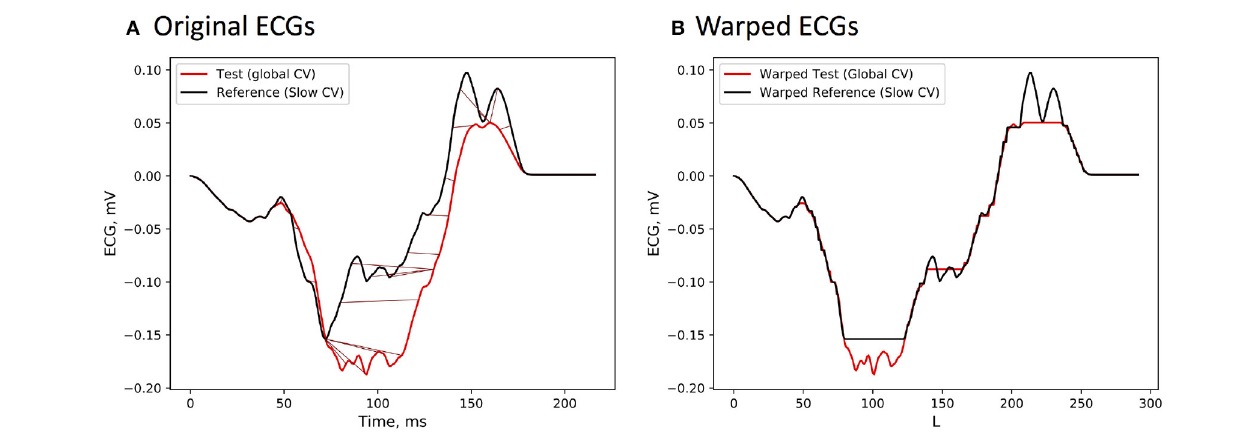
FIGURE 2 | (A) ECG signals from the reference BSPMs, which was computed from the activation sequence with locally modified CV value, and the test BSPMs generated by the standard FRA under the assumption of a global CV. The signals differ only on the time interval corresponding to the wavefront passing through the low CV region. (B) Temporally warped ECG sequences with the path length L .